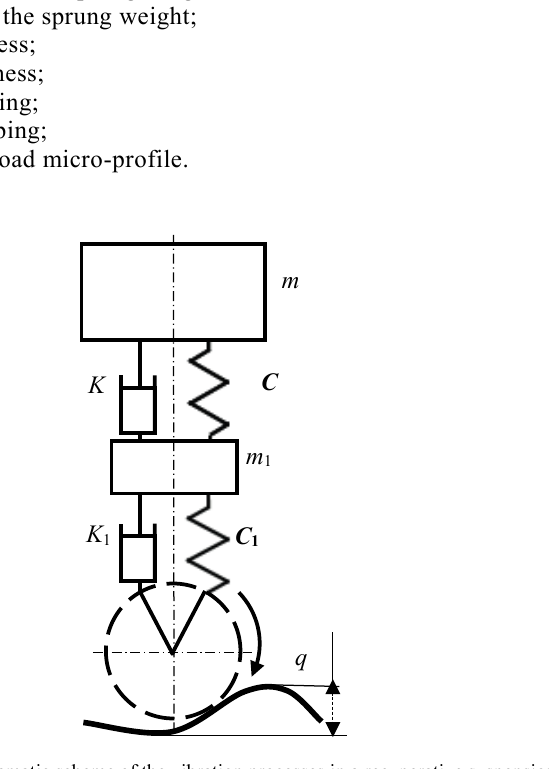
Fig. 5. The kinematic scheme of the vibration processes in a recuperative